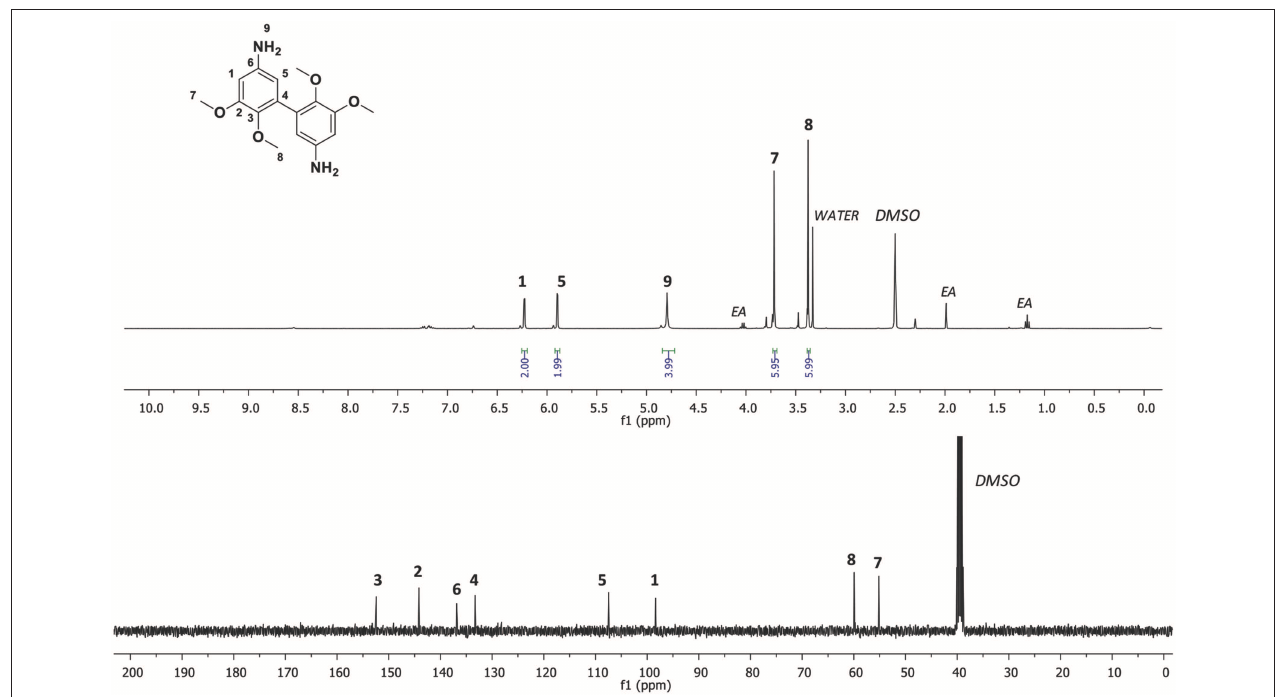
FIGURE 2 | 1 H and 13 C NMR spectroscopy of 3,4-dimethoxydianiline (DMAN) in DMSO-d6.